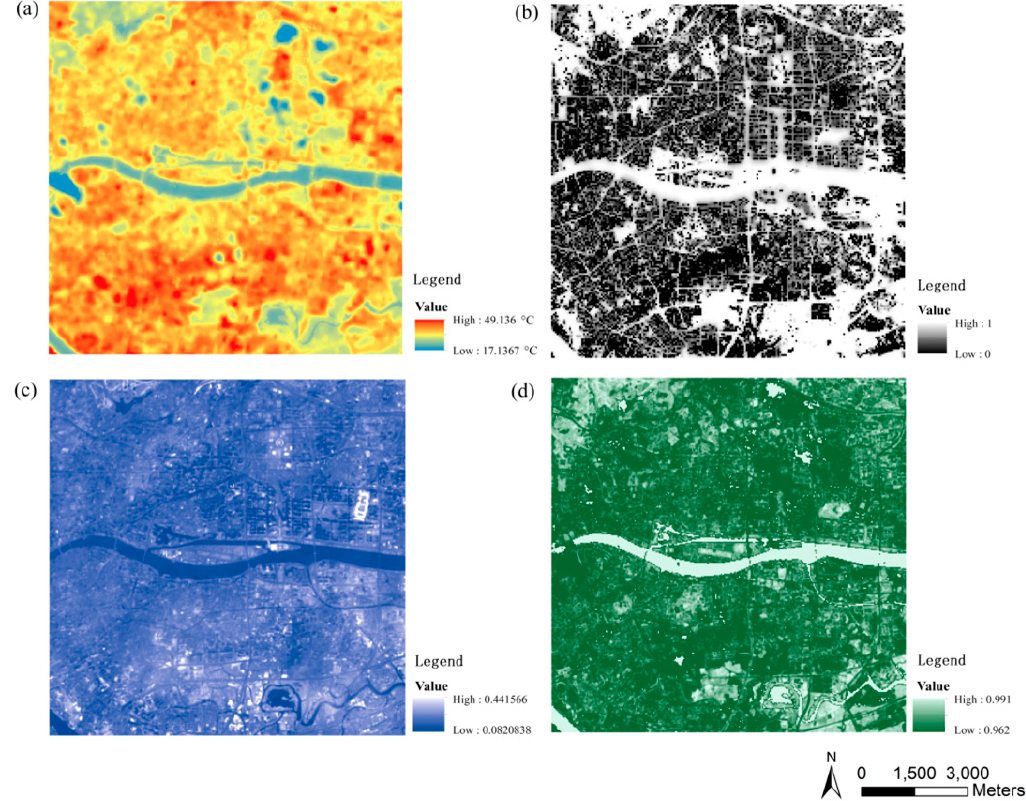
Figure 5. ( a ) Land surface temperature (LST), ( b ) sky view factor, ( c ) surface albedo, and ( d ) ground emissivity retrieval images for the central urbanized area of Guangzhou.